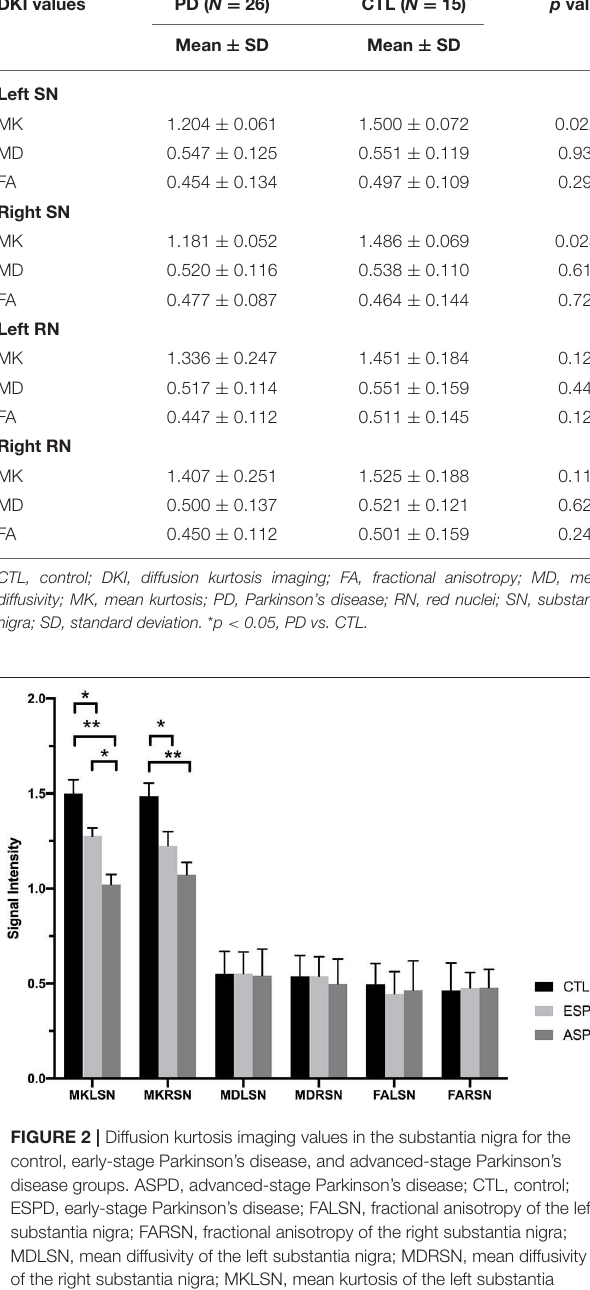
MK values in the bilateral red nucleus relative to controls. Hence, DKI may be a useful imaging technique for the diagnosis of PD and assessment of disease